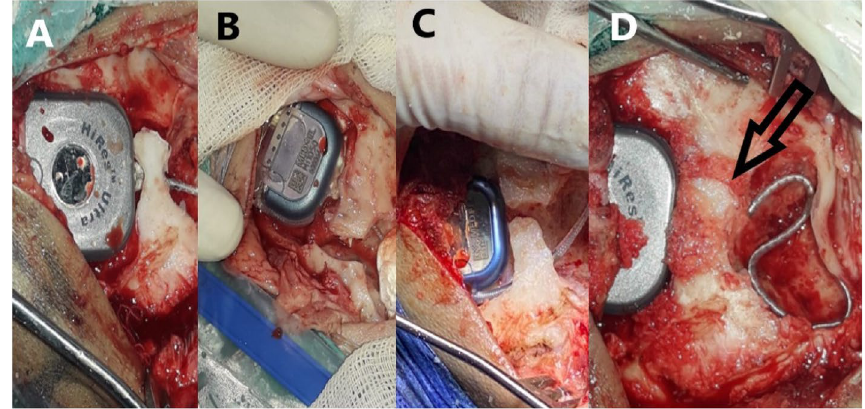
Fig. 3 A HiRes ultra RS in place with superior groove. B Concerto RS with mid-oriented wire lead with inferior groove. C Concerto RS with side-oriented wire lead with superior groove. D Bone dust being used to obliterate the tunnel and groove (black outined